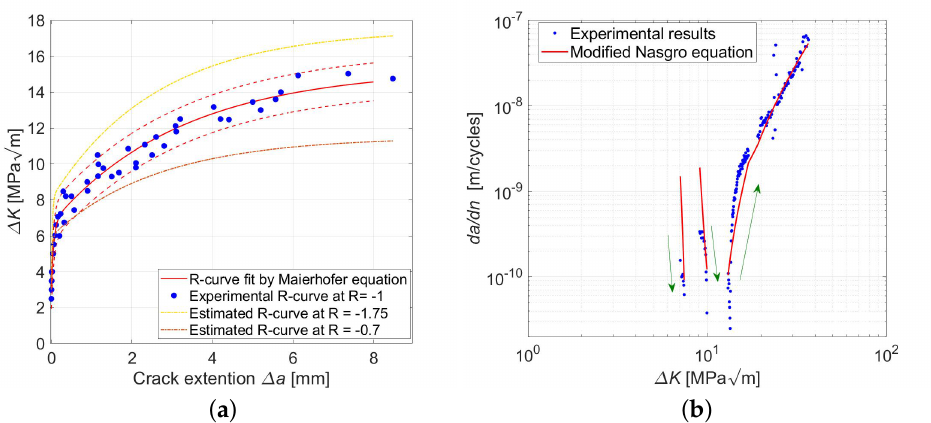
Figure 6. Modified Nasgro equation calibration: ( a ) crack growth threshold ∆ K th vs. crack exten- sion ∆ a (R-curve) and ( b ) growth of a short crack near the threshold region, comparison between experimental and predicted crack growth